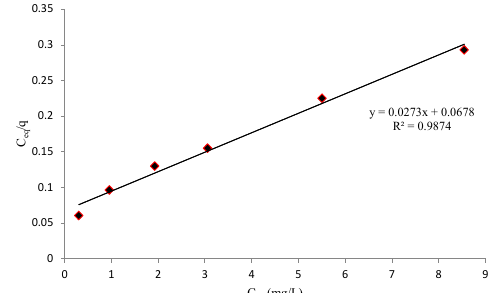
Fig.10: LangmuirisothermplotforadsorptionofHg(II)ontoFe 3 O 4 -Polyrhodanineat25 ◦ C Fig. 10. Langmuir isotherm plot for adsorption of Hg (II) onto Fe3O4-Polyrhodanine at 25 ◦C